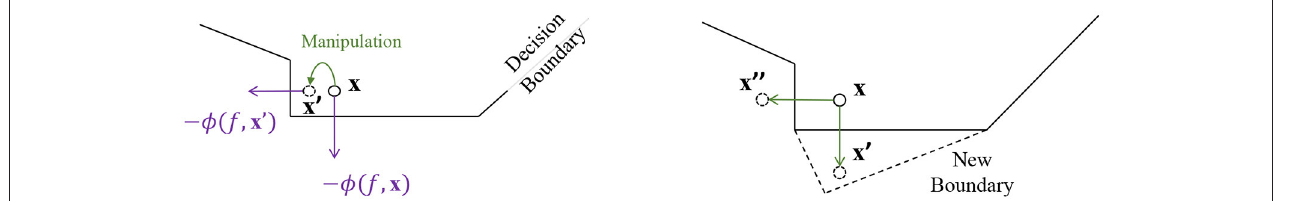
FIGURE 2 | Illustration of explanation instability that leads to adversarial training inefficiency.